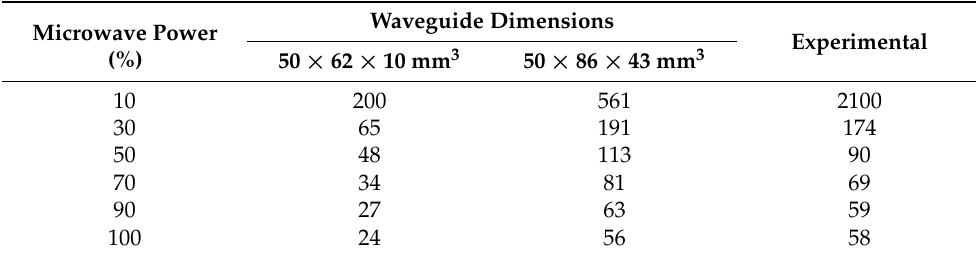
Table 5. Calculated times (seconds) of heating for rectangular waveguides and comparison with experimental data.